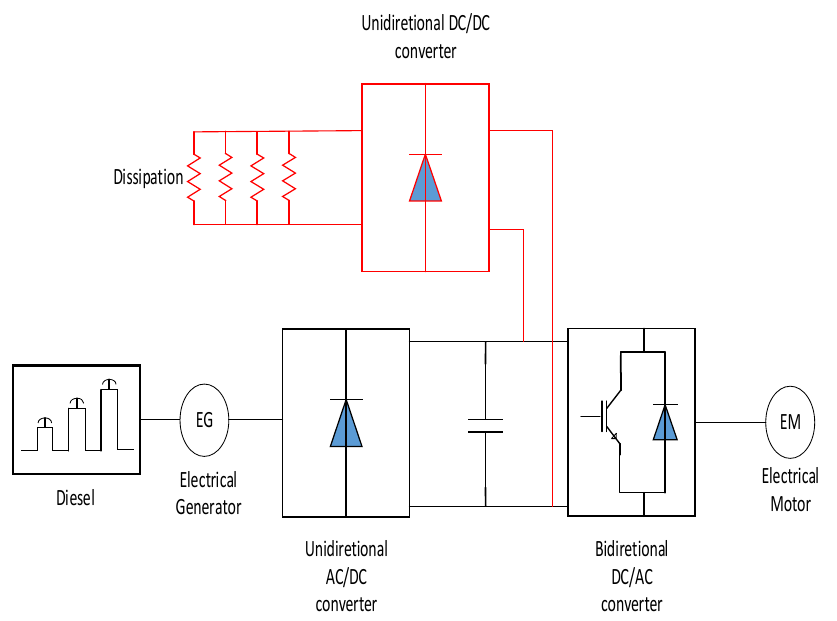
Figure 2. Schematic of diesel–electric power conversion chain with dissipation resistors [35].